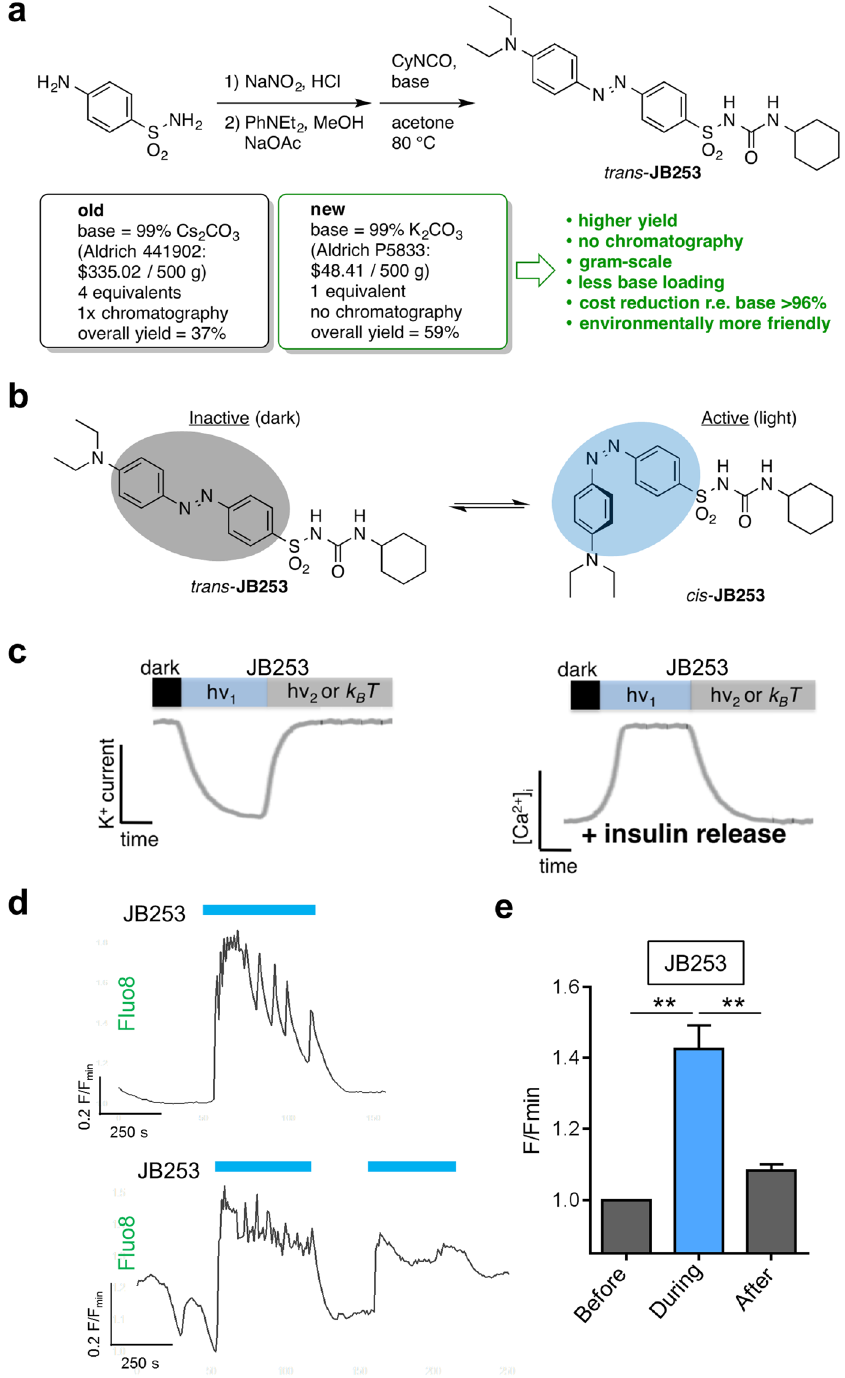
Figure 1. JB253 bulk synthesis. ( a ) An alternative synthetic route affords JB253 via crystallization and no chromatography from 1 equivalent of base in the second step. This can be easily performed on the gram-scale, is more environmentally-friendly and allows significant cost reductions and enhanced yield. ( b ) trans -JB253 (dark) is inactive, whereas illumination with blue light leads to cis- isomerization and activation. ( c ) Schematic showing that exogenously-applied JB253 closes K ATP channels, leading to membrane depolarization, Ca 2 + influx and insulin release. This process can be switched back and forth using light of the appropriate wavelength, or the dark (hv 1 = photon energy needed for isomerization to achieve channel closure; hv 2 = photon energy needed for isomerization to achieve channel opening, also achievable by thermal relaxation k B T ) (see also ref. 10). ( d ) Representative traces showing that JB253 produced using bulk synthesis allows the reversible optical control of Ca 2 + fluxes in vitro in isolated pancreatic islets incubated with 8 mm D -glucose. ( e ) As for ( d ), but summary bar graph showing Ca 2 + levels before, during and after illumination with blue light (representative traces; n = 9 recordings from 3 animals). ** P < 0.01; repeated measures one-way ANOVA (Bonferroni’s posthoc test). Values represent mean +